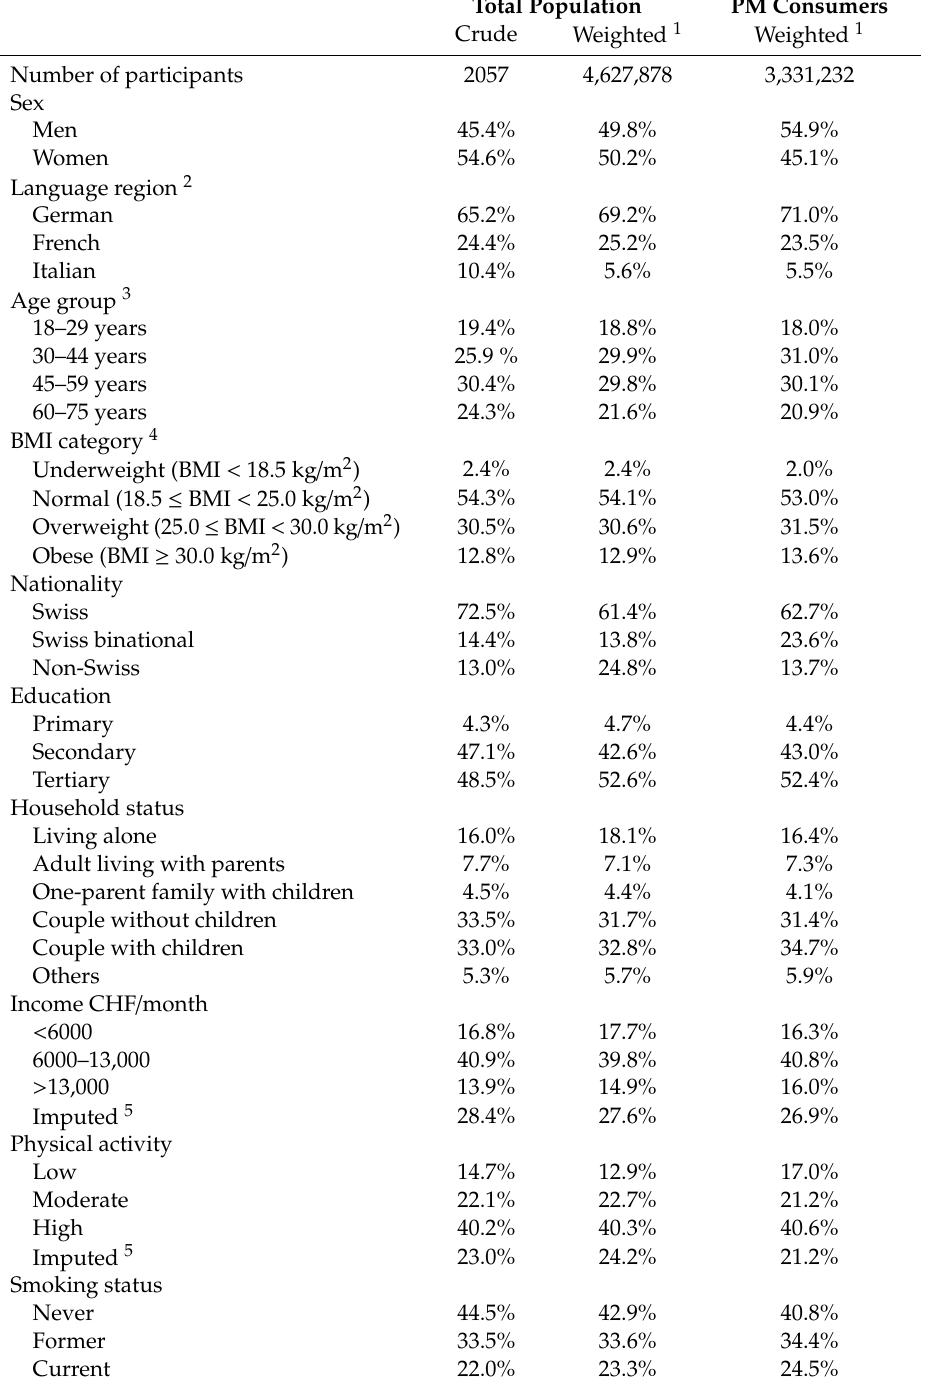
Table 1. Description of total population and processed-meat